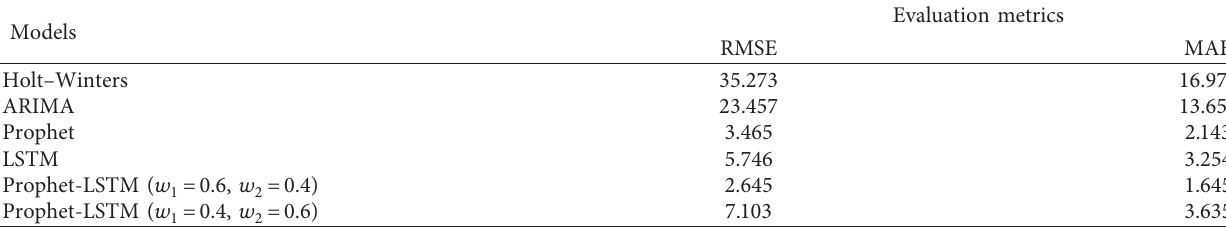
Table 2: Comparison of the performance of different